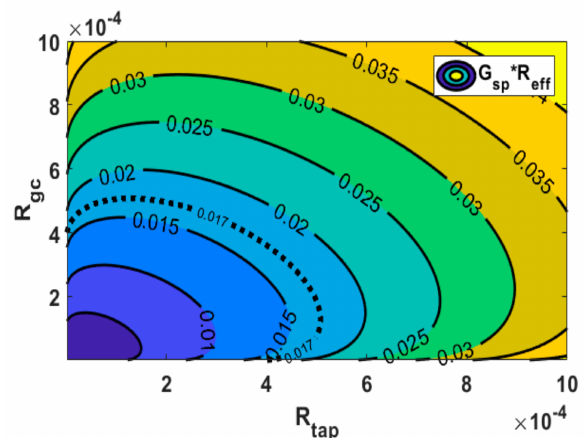
Figure 6. Range of NTW_SOA operation versus the GC and tapered reflectivity. Lines separate the boundary with di ff erent residual facet reflectivities (RFR). The dot line marks the boundary with G sp R = 0.017 which corresponds to the 0.3 dB-ripples limit for 16.5 dB single pass gain.